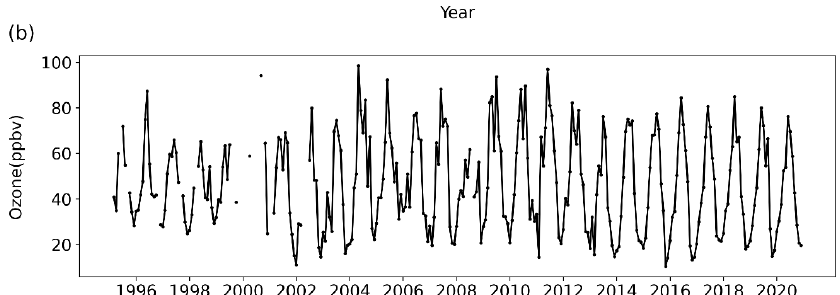
Figure 5. ( a ) The monthly average ozone mixing ratio in Beijing measured by IAGOS (blue, below 990 hPa), the IAP ozonesonde (red, below 100 m) and the MEE (black, surface). ( b ) Surface ozone mixing ratio in Beijing for 1995–2020 based on merging the three data sets (see text for